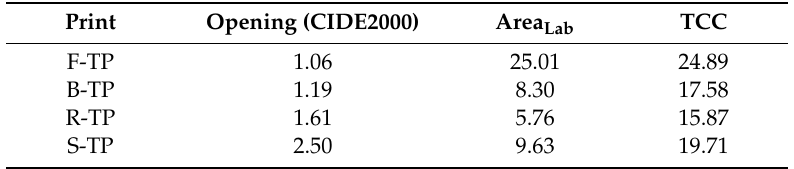
Table 6. The parameters used for evaluation of the dynamic color change: opening measured at 15 ◦ C, surface area (Area Lab ), and total color contrast (TCC).